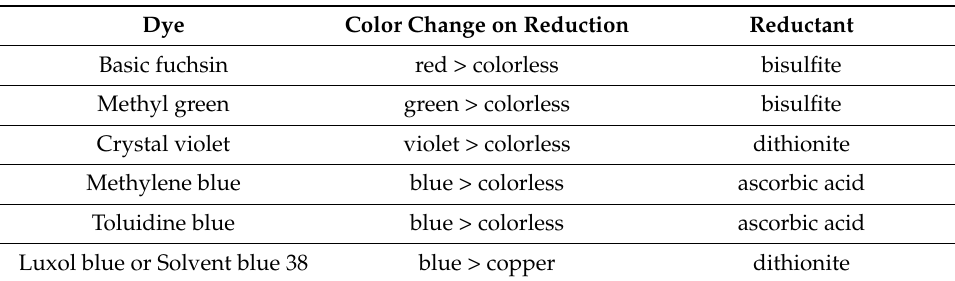
Table 2. Oxidation–reduction sensitive